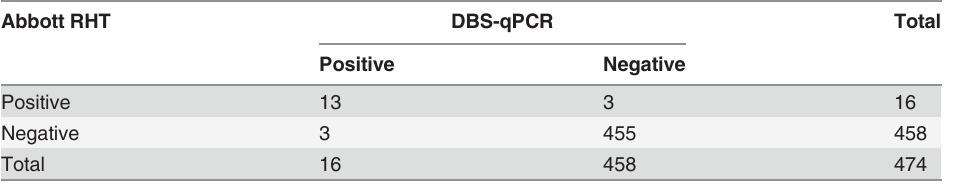
Table 2. Comparison of DBS-qPCR and RHT test